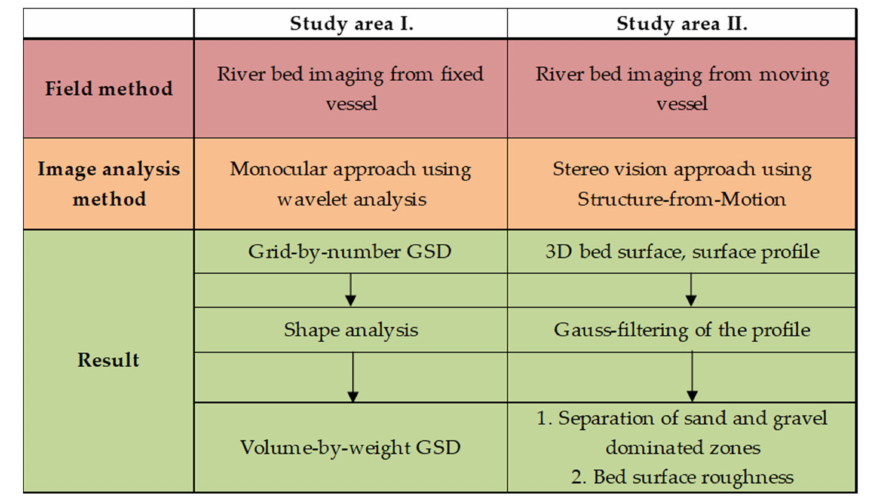
Figure 3. Overall flowchart of the measurements and used analysis methods with their expected